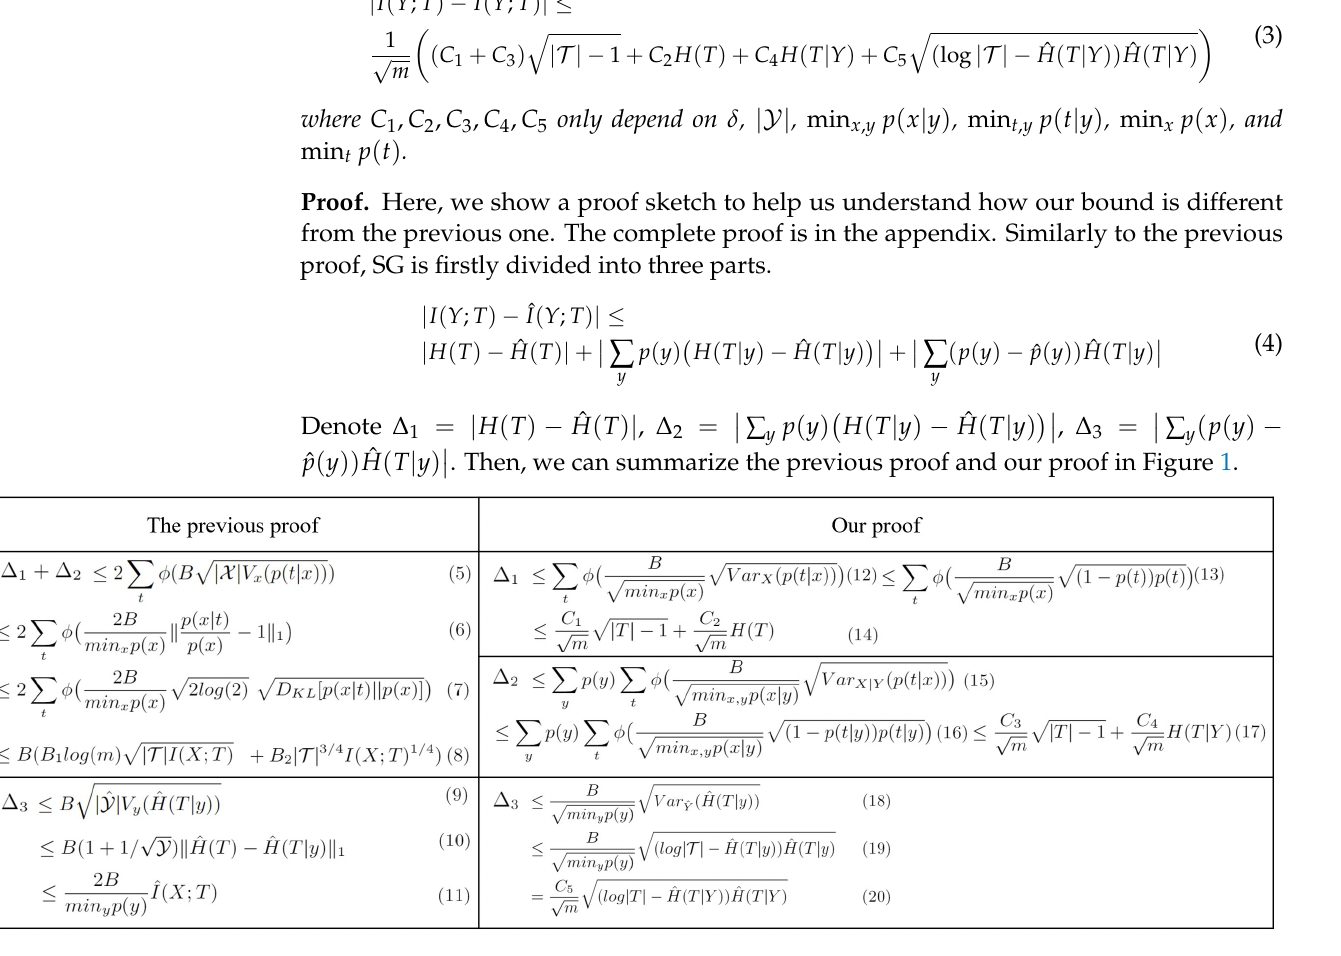
Figure 1. The previous proof vs. our